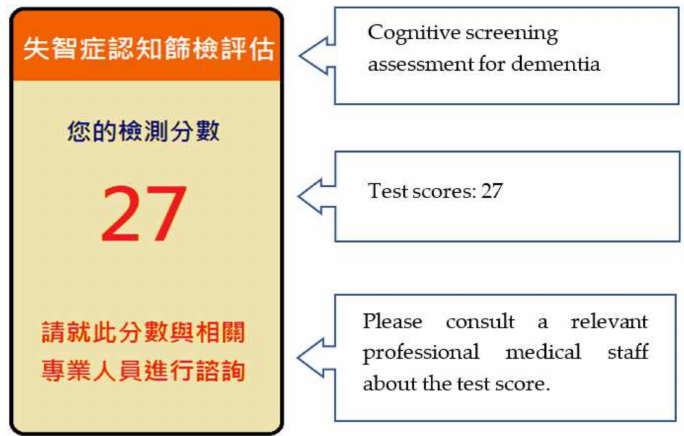
Figure 12. The test results screen shown on the mobile